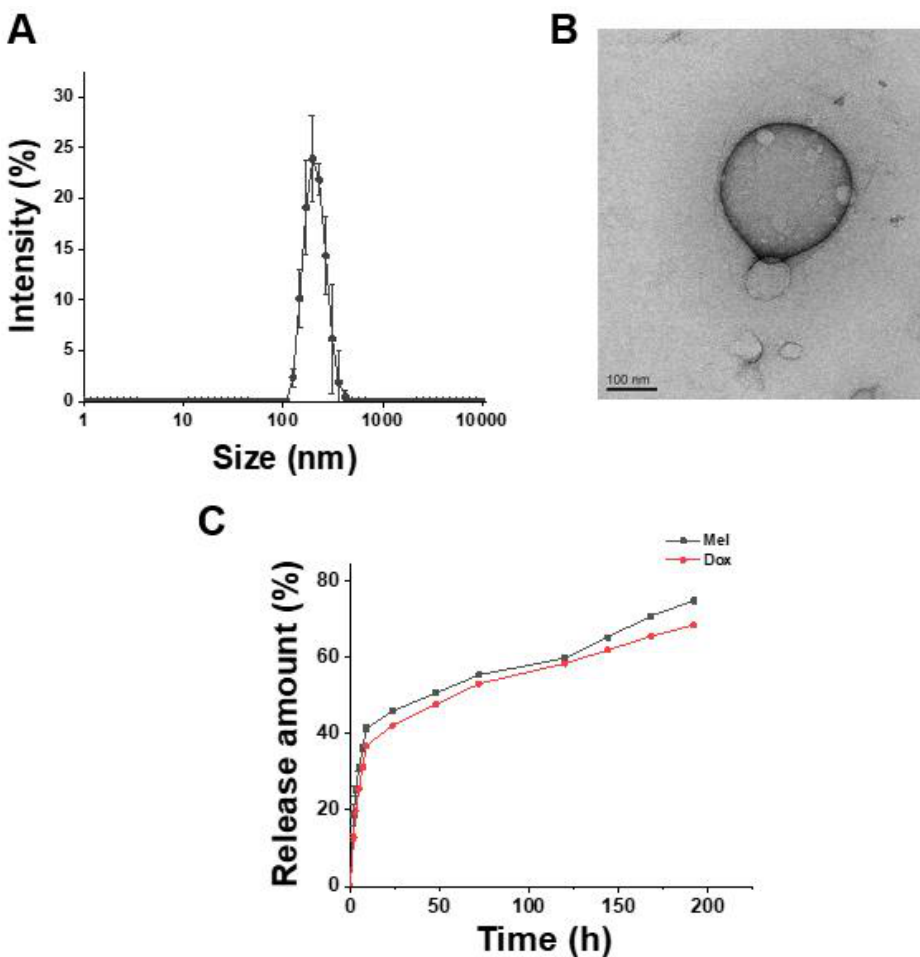
Figure 2. Characteristics of the Dox-Mel polymersome. ( A ) Size distribution of Mel PL and Dox-Mel PL. ( B ) TEM image of Dox-Mel PL. Scale bar represents 100 nm. ( C ) In vitro release profile of doxorubicin and melittin from Dox-Mel